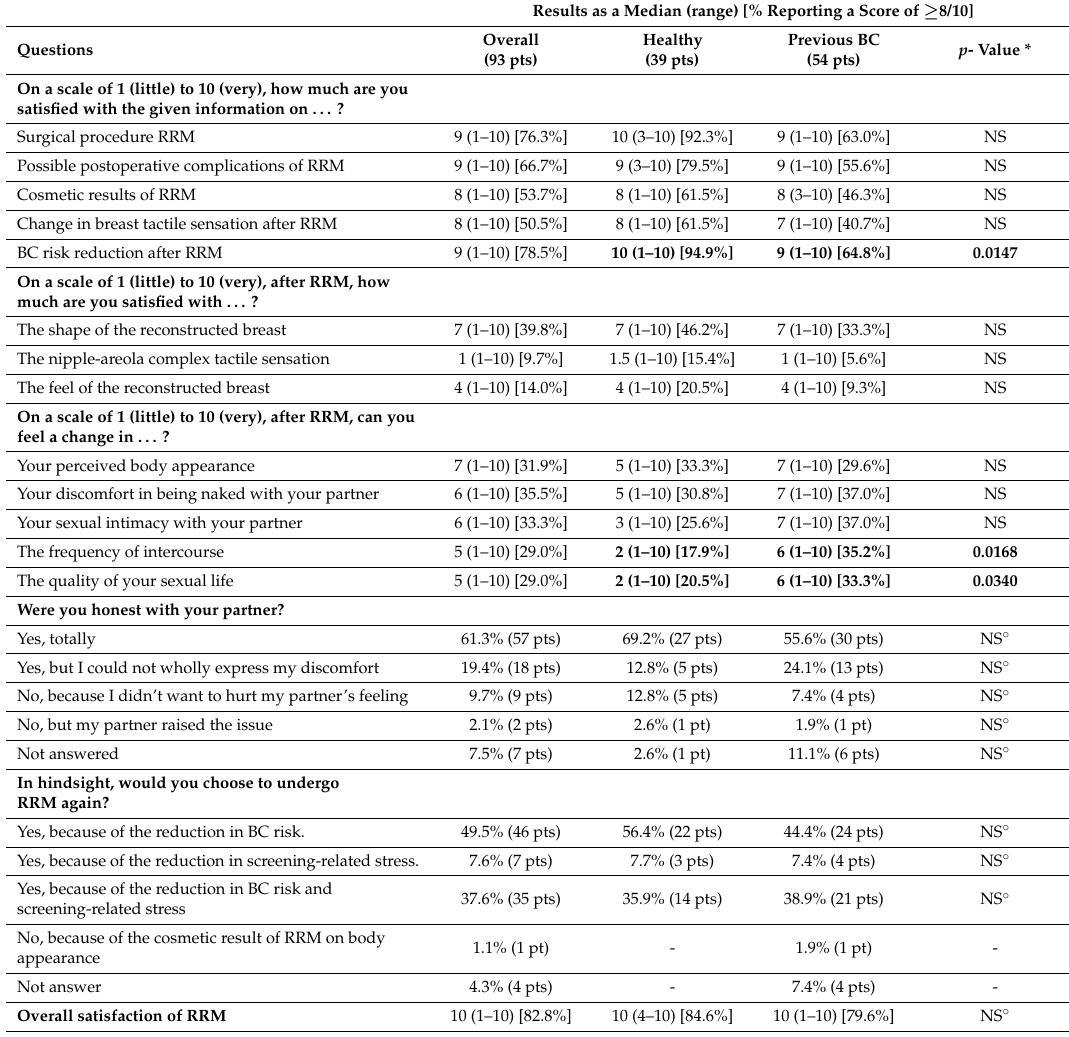
Table 3. Satisfaction and concerns among carriers, who underwent Risk-Reducing Mastectomy (RRM), considering their medical history (healthy carriers and those with a previous